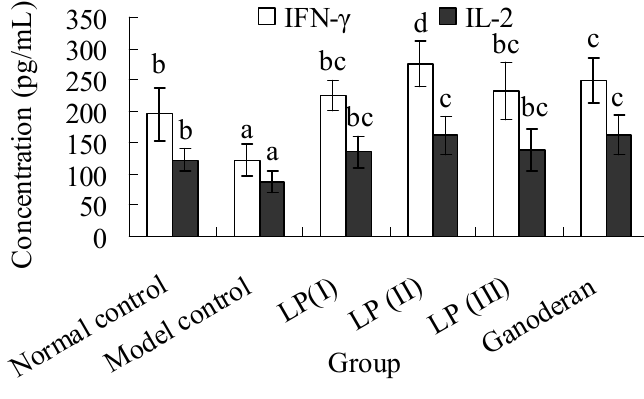
Figure 2. Effect of longan pulp polysaccharide-protein complex LP3 on IFN- γ and IL-2 production. The levels of INF- γ and IL-2 in mice serum were quantified by an ELISA kit. Data presented were means ± standard deviation (n = 10). The significant differences among the groups were evaluated with ANOVA followed by the S-N-K test. Columns with different letters are significantly different ( P <